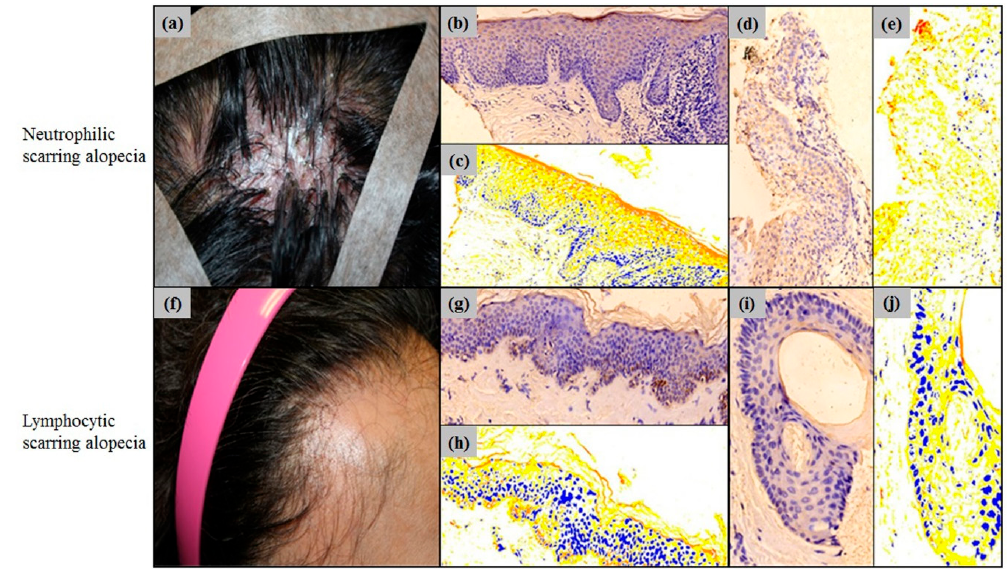
Figure 5. ( a ) Representative clinical photograph of neutrophilic scarring alopecia showing folliculitis decalvans; ( b ) Erdr1 staining patterns of the epidermis in neutrophilic scarring alopecia; ( c ) HistoQuant™ measurement for the intensity of Erdr1 expression; Red—strong positive; orange—moderately positive; yellow—weakly positive; blue—negative nuclei; white—negative pixels; ( d ) Erdr1 staining patterns of the hair follicle in neutrophilic scarring alopecia; ( e ) HistoQuant™ measurement for the intensity of Erdr1 expression in the hair follicle of neutrophilic scarring alopecia; ( f ) Representative clinical photograph of lymphocytic scarring alopecia showing frontal fibrosing alopecia; ( g ) Erdr1 staining patterns of the epidermis in lymphocytic scarring alopecia; ( h ) HistoQuant™ measured the intensity of epidermal Erdr1 expression in lymphocytic scarring alopecia; ( i ) Erdr1 staining patterns of the hair follicle; ( j ) HistoQuant™ measured the intensity of Erdr1 expression in the hair follicle; Erdr1 immunostaining, original magnification ( b – e , g , h ) ×200; ( i , j ) ×400.